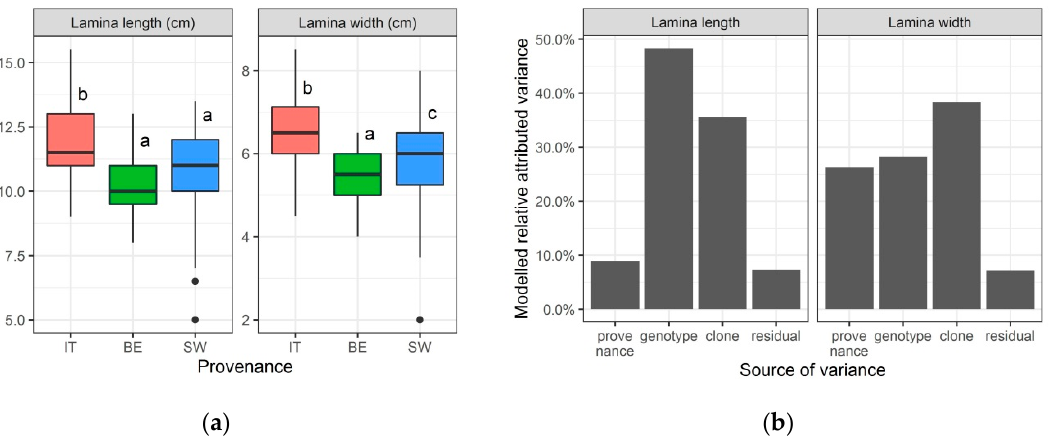
Figure 3. Leaf lamina length, lamina widest width and their ratio for the three provenances. ( a ) Box plots of the measurements. Letters indicate significant differences (Table S1); ( b ) Modelled distribution of the relative variance. Variance is explained by the factors provenances, genotypes within a provenance and clones within a genotype. IT: Italian provenance, BE: Belgian provenance, SW: Swedish provenance.